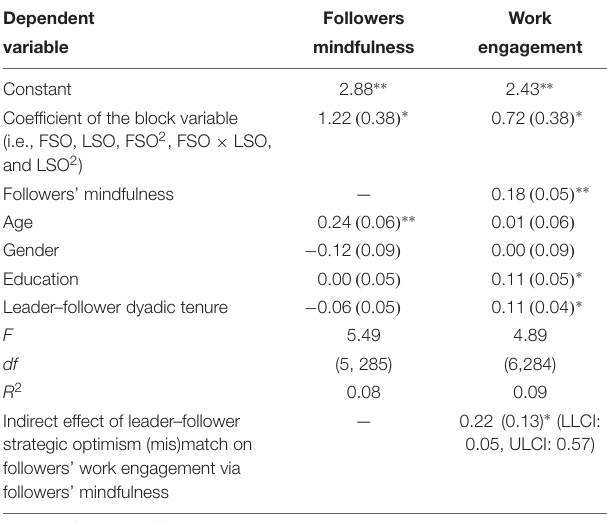
TABLE 3 | Results of the mediating analyses with the PROCESS